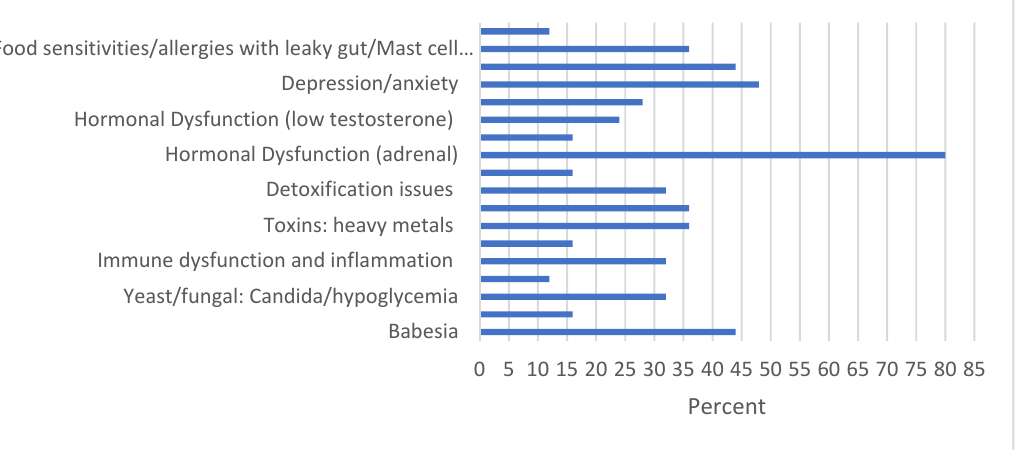
Figure 1. MSIDS variables in 25 patients with CLD/PTLDS: Abbreviations: Non-alcoholic steatohep- atitis (NASH), mast cell activation disorder (Mast Cell).